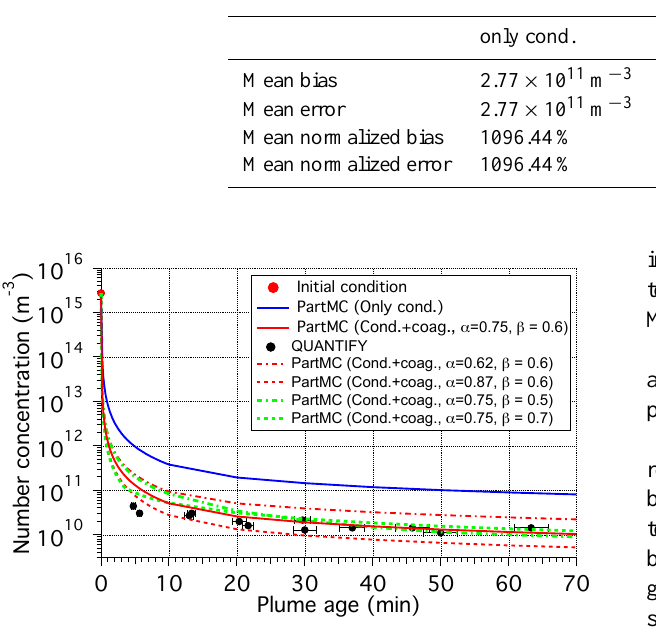
the production of secondary aerosol species is largely deter- mined by the exposure time to sunlight during